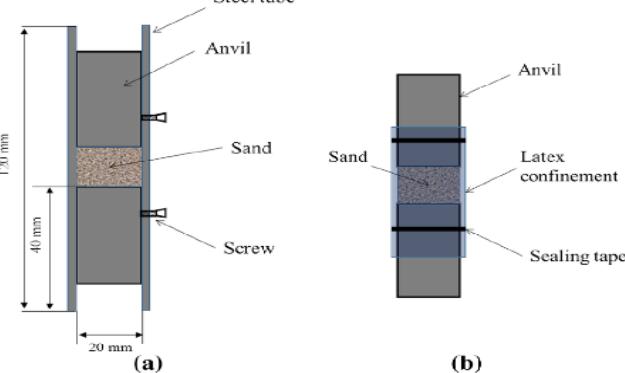
Figure 8. View of a casing made of ( a ) stainless steel and ( b ) latex (reprinted from Ref. [74]).